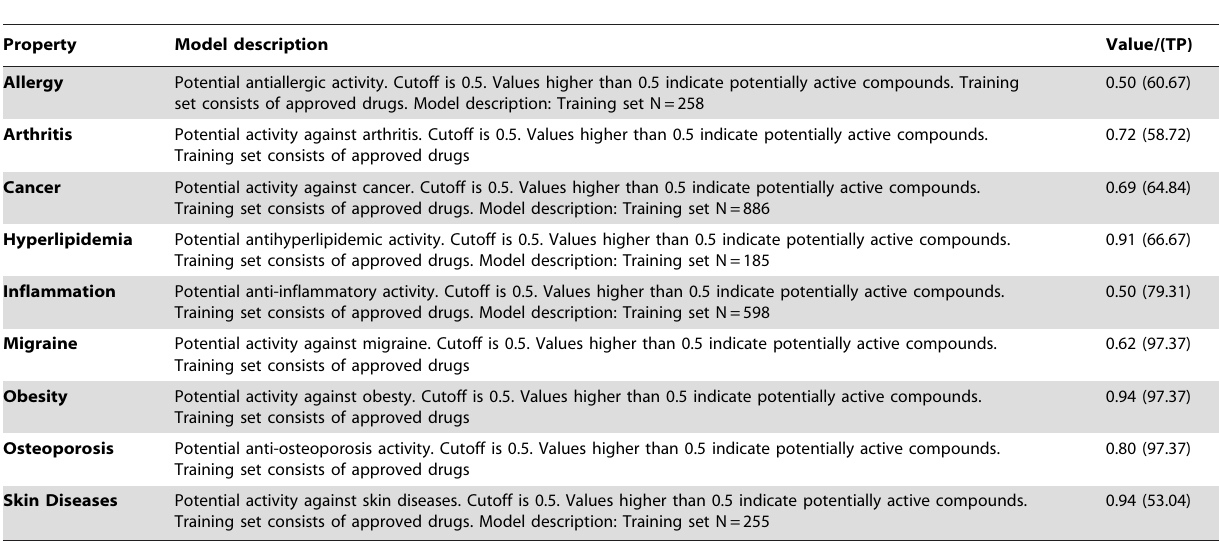
Table 6. Predicted therapeutic activity of UA against various reported diseases.